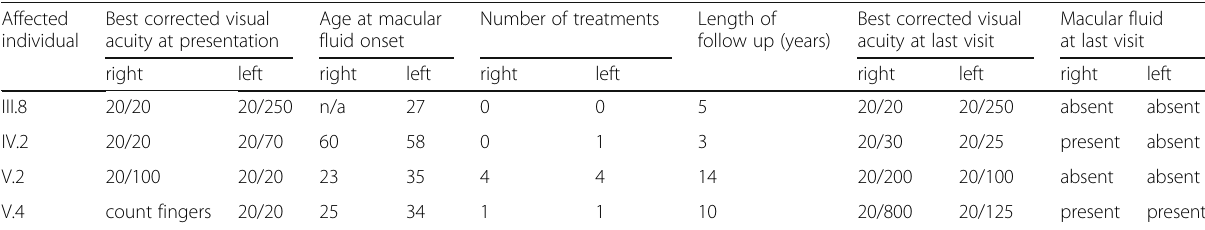
Table 1 Clinical histories of affected individuals in cavitary optic disc anomaly pedigree Affected Best corrected visual Age at macular Number of treatments Length of Best corrected visual Macular fluid individual acuity at presentation fluid onset follow up (years) acuity at last visit at last visit right left right left right left right left right